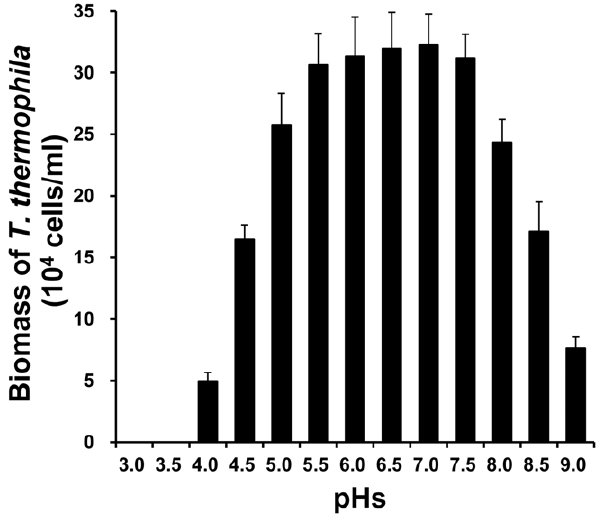
Figure 4. Effect of different pHs on the growth of T.thermophila. Biomass of T. thermophila was measured after cultured in different pH SPP medium for 12 h. Data are expressed as the mean 6 SD of six measurements per time point.